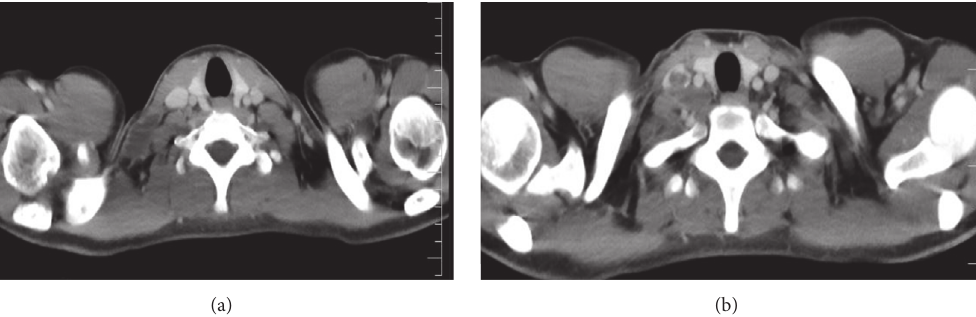
Figure 4: Axial CECT neck showing well-defined hypodense lymph node in the right supraclavicular region and posterior to right CCA and IJV at level IV showing peripheral rim enhancement with central caseation necrosis eroding through the posterior wall of right IJV with filling defect in contrast filled IJV lumen suggestive of thrombus.